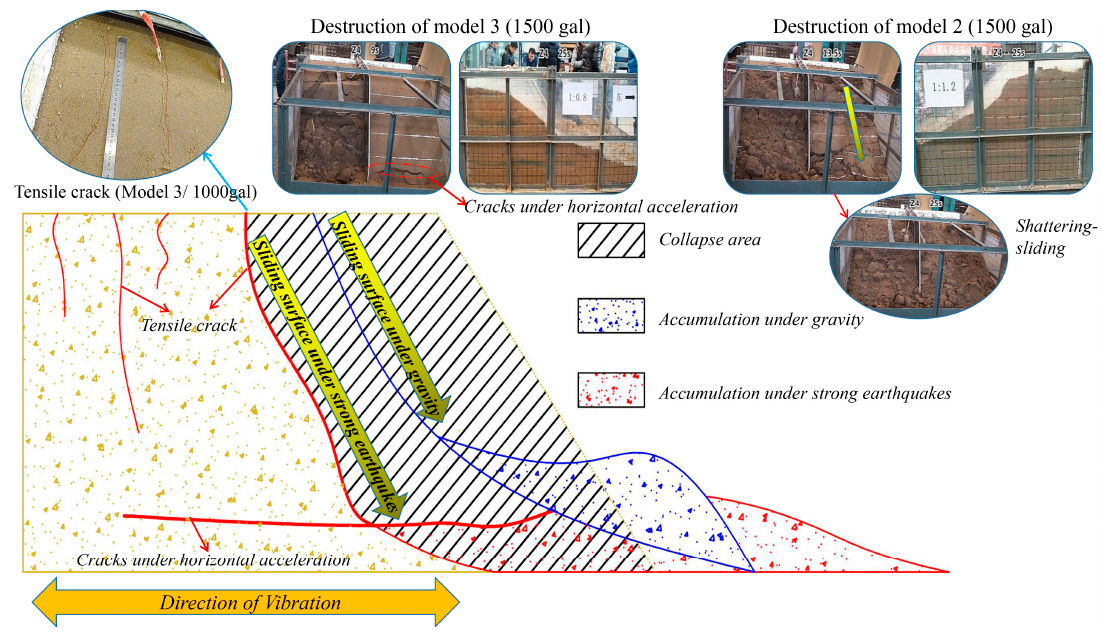
Figure 13. Tension-shattering sliding of model 2 and model 3.